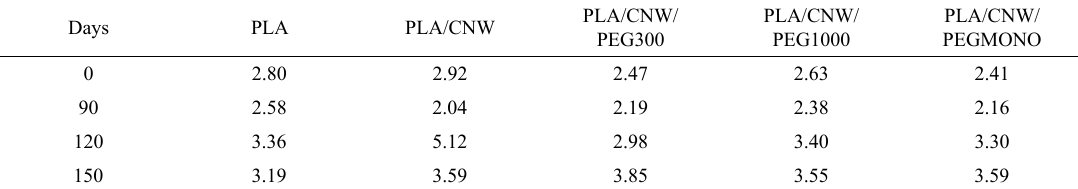
Table 2. Values of carbonyl index of neat PLA and PLA nanocomposites films before and after different exposure times in